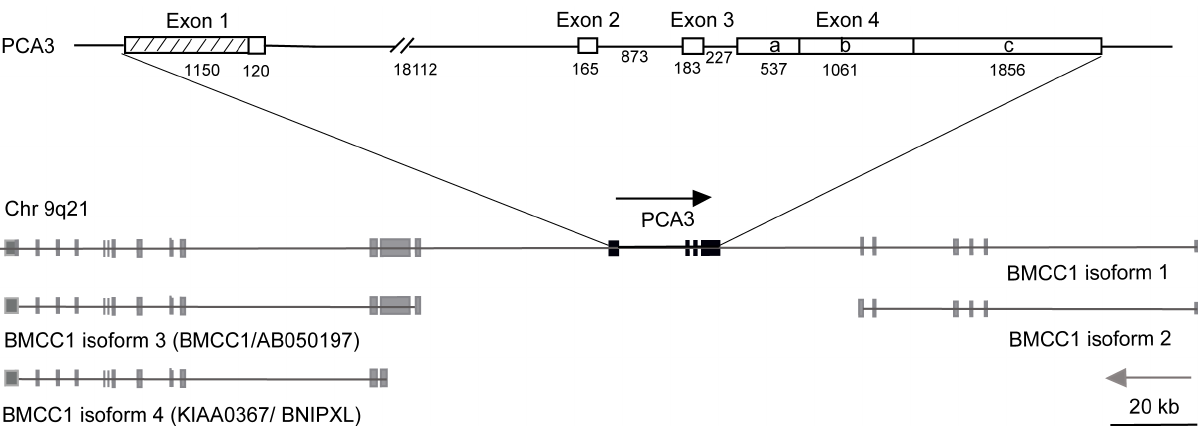
Figure 2. Redefined PCA3